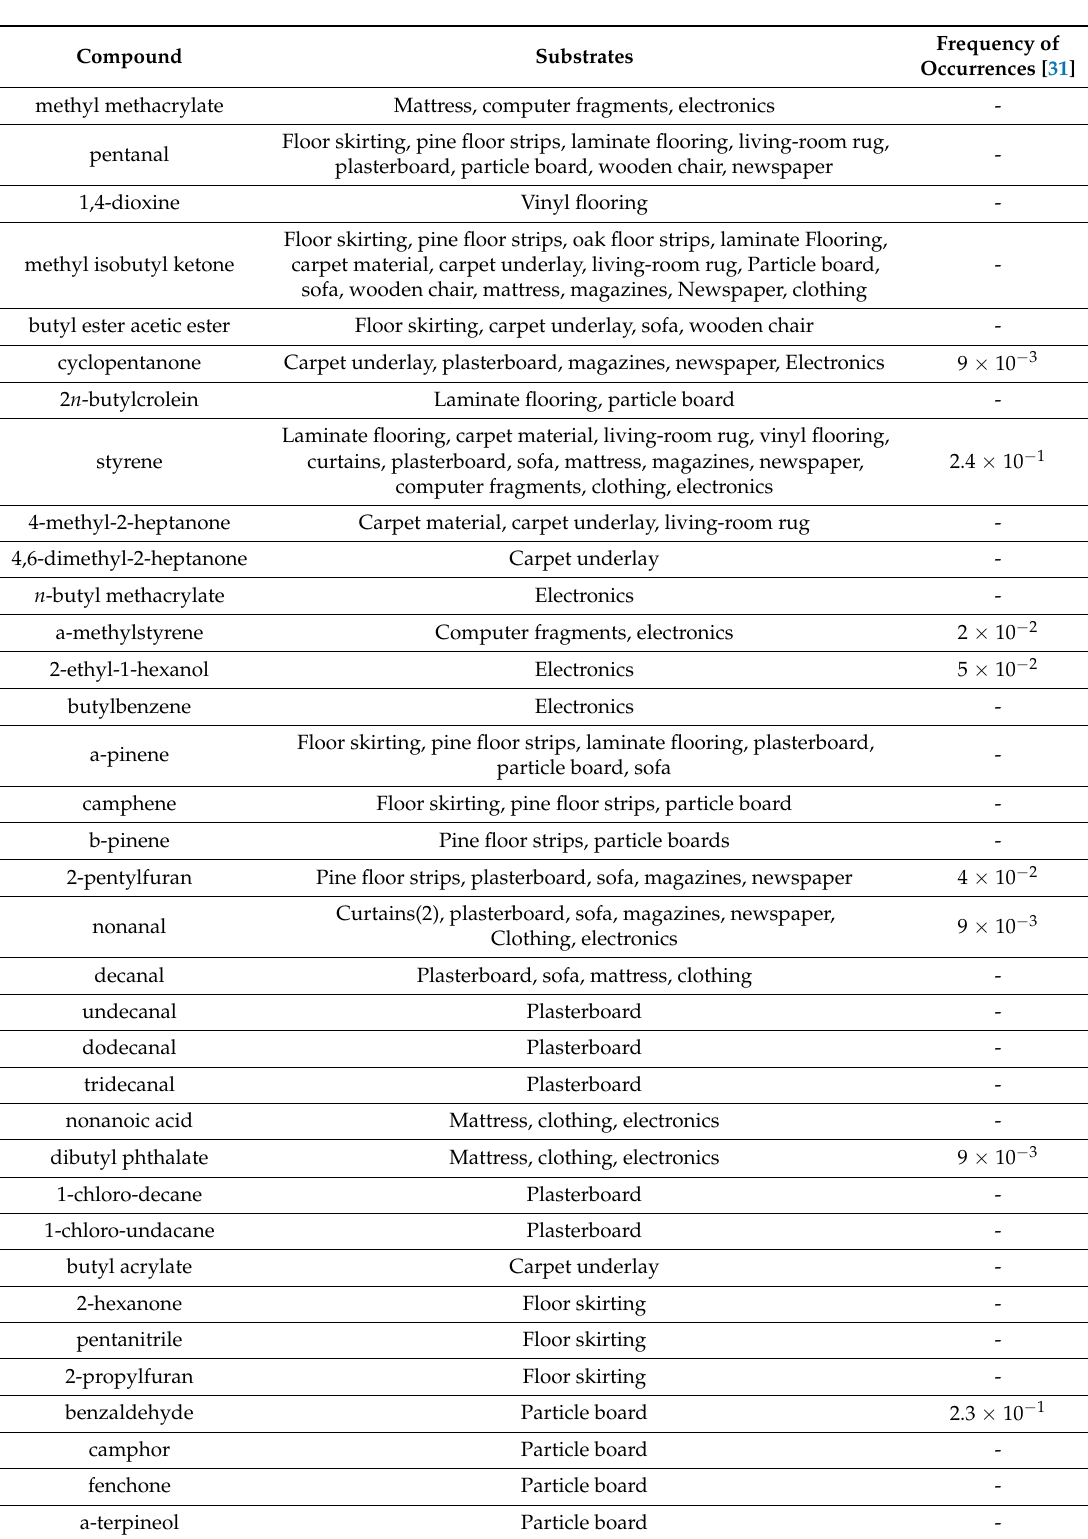
Table 4. Compounds identified from substrate fire experiments and not found in the intact ILs with the corresponding frequency of occurrences from Appendix D of the Sigman group